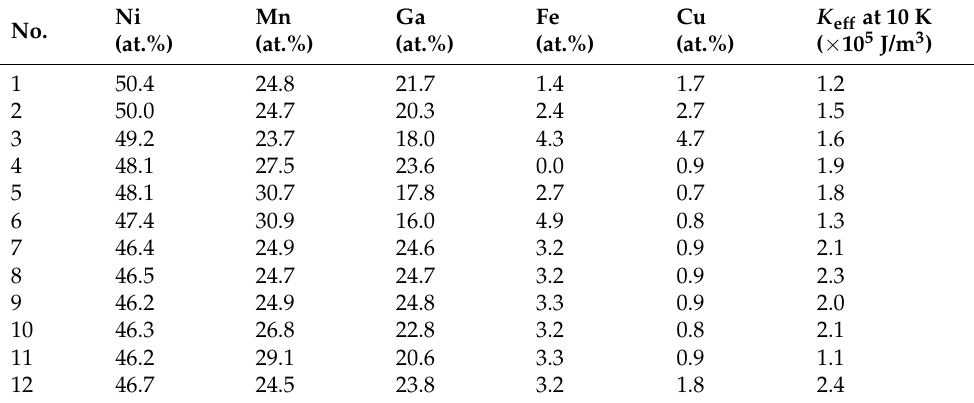
Table 1. Effective magnetic anisotropy K eff at 10 K calculated from magnetization curves in Ni-Mn-Ga alloyed by small amount of Fe and Cu. Experimental composition (at.%) determined by XRF is quoted. All samples listed in the table are in martensite state at 10 K.